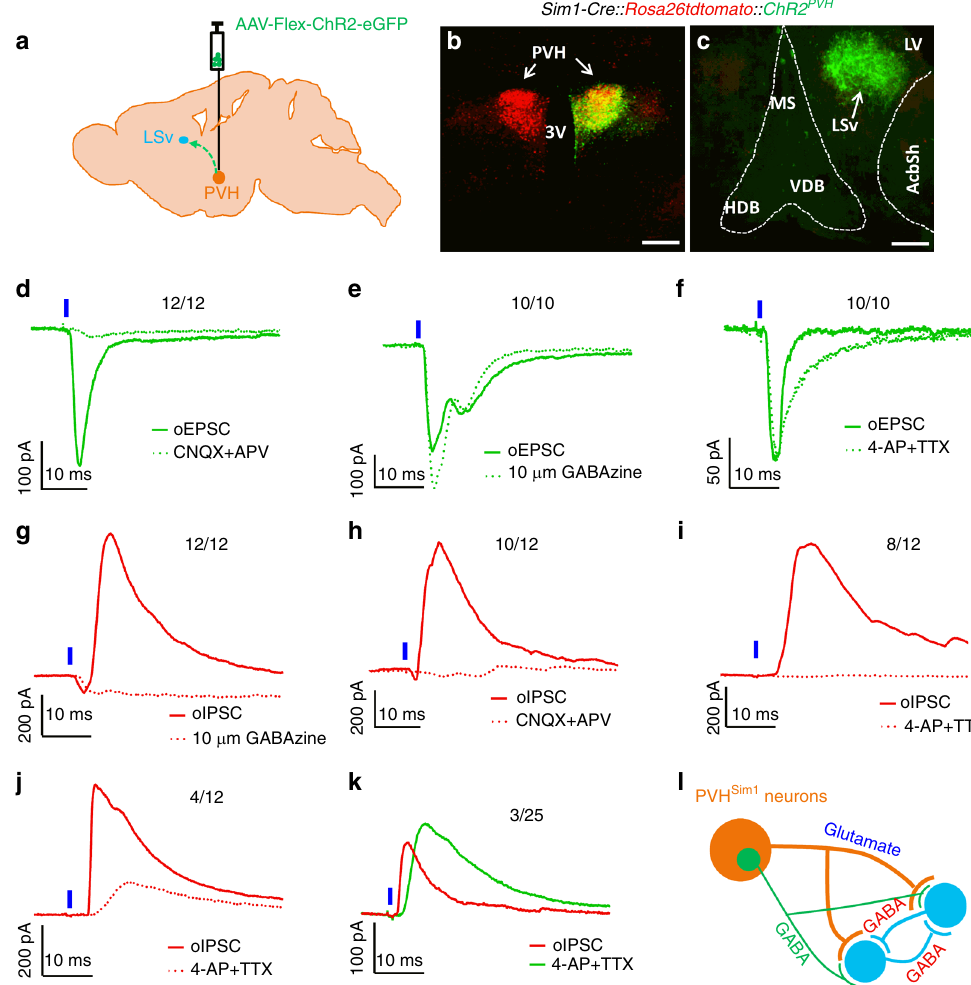
Fig. 1 A local GABAergic network in the ventral part of lateral septum (LSv) receives direct glutamatergic input from PVH neurons. a – c Sim1-Cre reporter mice (four males and two females) received injections of AAV-Flex-ChR2-eGFP vectors to one side of the PVH a , facilitating dual expression of the ROSA- lsl-tdTomato allele in Sim1-Cre neurons, and unilateral targeted expression of the AAV-Flex-ChR2-eGFP b . c GFP-expressing fi bers from the PVH shown in the ventral part of lateral septum (LSv) were observed 4 weeks after AAV-delivery. d – k Patch clamp recording of randomly selected neurons in LSv in brain slices from Sim1-Cre d – j or Sim1-Cre::Vglut2 fl ox/ fl ox mice k with photostimulation of PVH → LSv fi bers. d – f Voltage – clamp recordings for photostimulated (1 ms, blue ticks) excitatory postsynaptic currents (EPSCs) and their responses to glutamate receptor antagonists (CNQX + APV) d , GABA-A receptor antagonists (GABAzine) e , and 4-AP + TTX to block action potentials f . g – j Voltage – clamp recordings with photostimulation (1 ms, blue ticks) to monitor inhibitory postsynaptic currents (oIPSCs) and their responses to GABAzine g , CNQX + APV h , 4-AP + TTX i and j . i and j showed the recording from the same set of neurons with complete i or partial blockage j by 4-AP/TTX. k Only three out of 25 recorded neurons showed 4-AP/TTX-resistant IPSC in Sim1- Cre::Vglut2 fl ox/ fl ox mice. The ratios at the top of traces indicate the number of neurons that exhibited responses to drugs out of all neurons showing postsynaptic currents. l A diagram derived from the recording data depicting a GABAergic network in the LSv receiving monosynaptic projections from the PVH comprising a major glutamatergic, and minor GABAergic components. Scale bar = 100 µ M . PVH: paraventricular hypothalamus; LSv: ventral part of lateral septum; MS; medial septum; HDB and VDB: diagonal band (horizontal and vertical); LV: lateral ventricle; 3 V: the third ventricle;